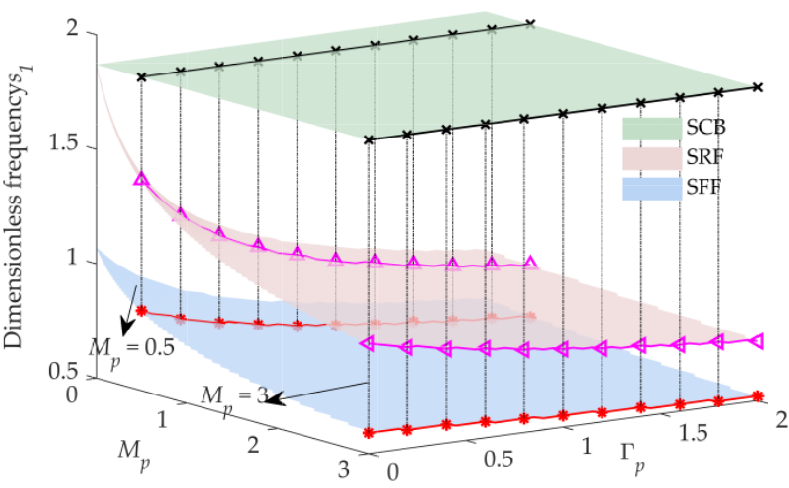
Figure 6. 3D surfaces of the first frequency versus M p and Γ p ( k m =